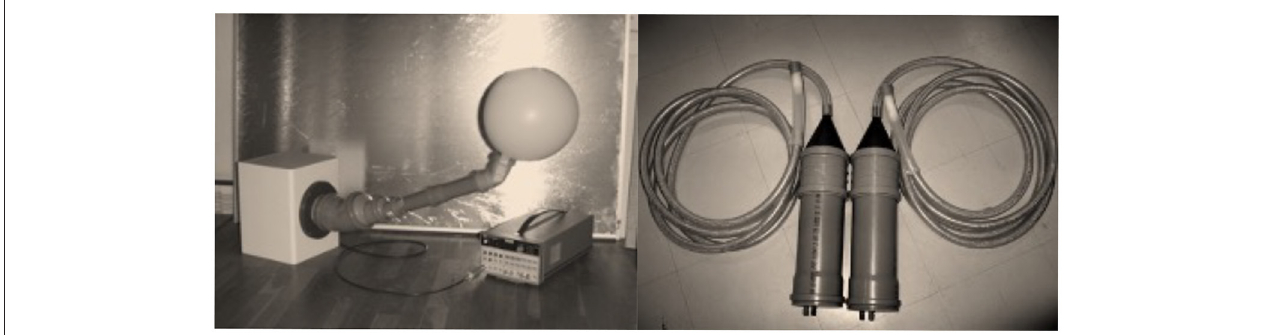
FIGURE 1 | Left: The evolution of the house-built vibrotactile stimulator. The original vibrotactile stimulator was used to investigate a congenitally deaf adult (32). Right: The evolution version with a dedicated band-pass (100–500Hz) filter was used later (33–35). Note that the original version has a balloon which vibrates by sound elicited by a standard loudspeaker whereas the later version uses a blind-ended silicone tube contributing to the reduced auditory contamination. White noise masking was typically used to reduce the auditory contamination.